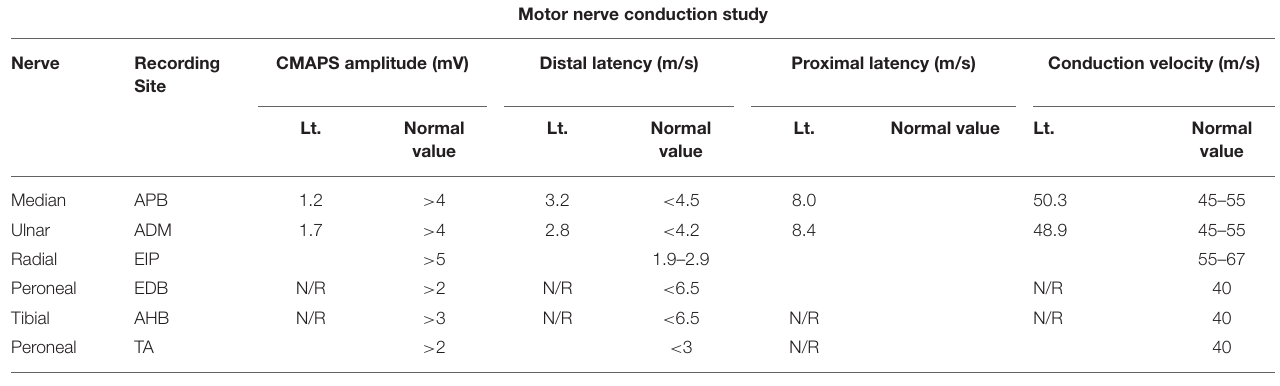
TABLE 2 | Neuro-electrophysiology report of the